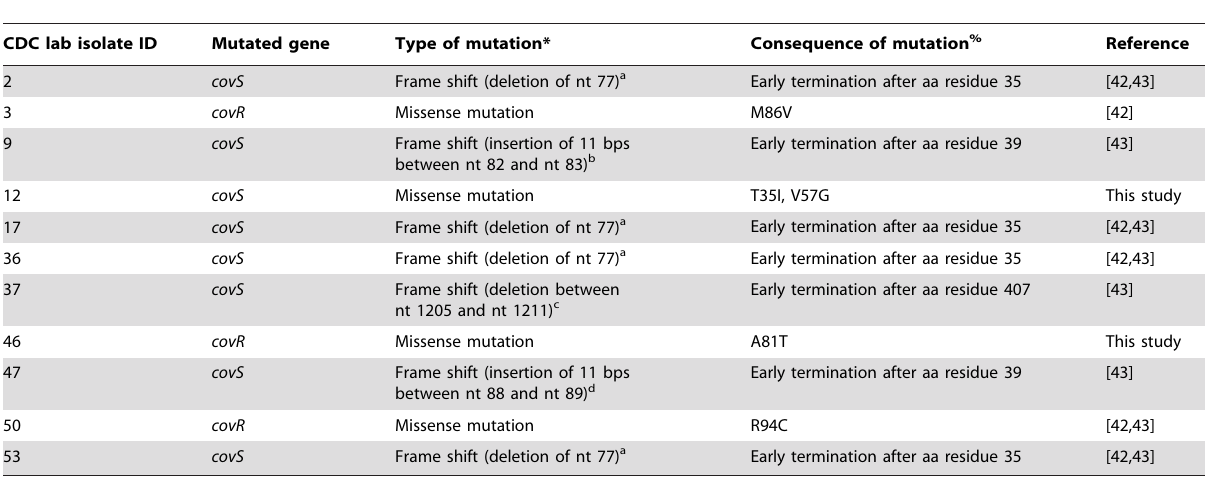
CDC lab isolate